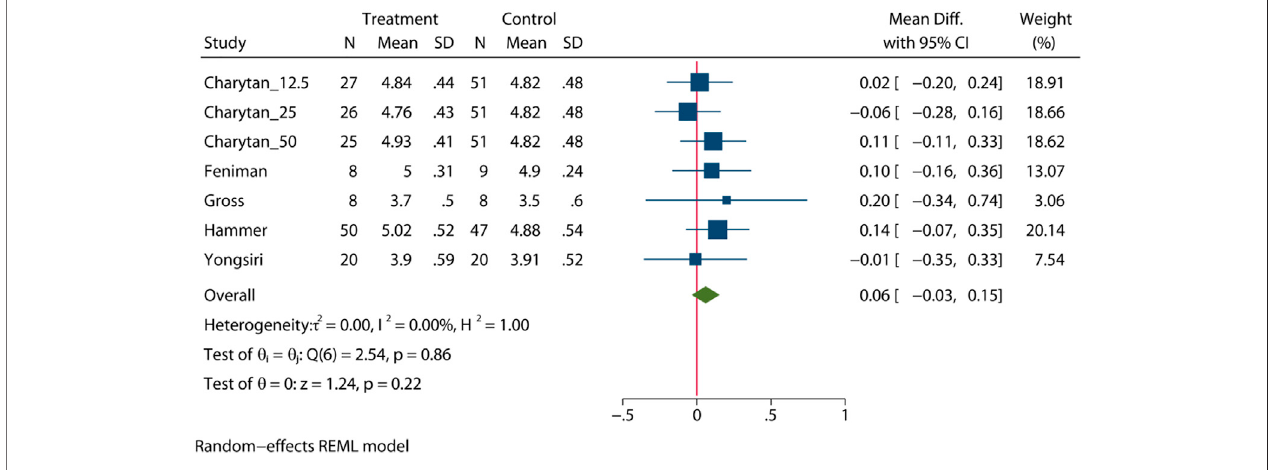
FIGURE 6 | Forest plot of serum potassium